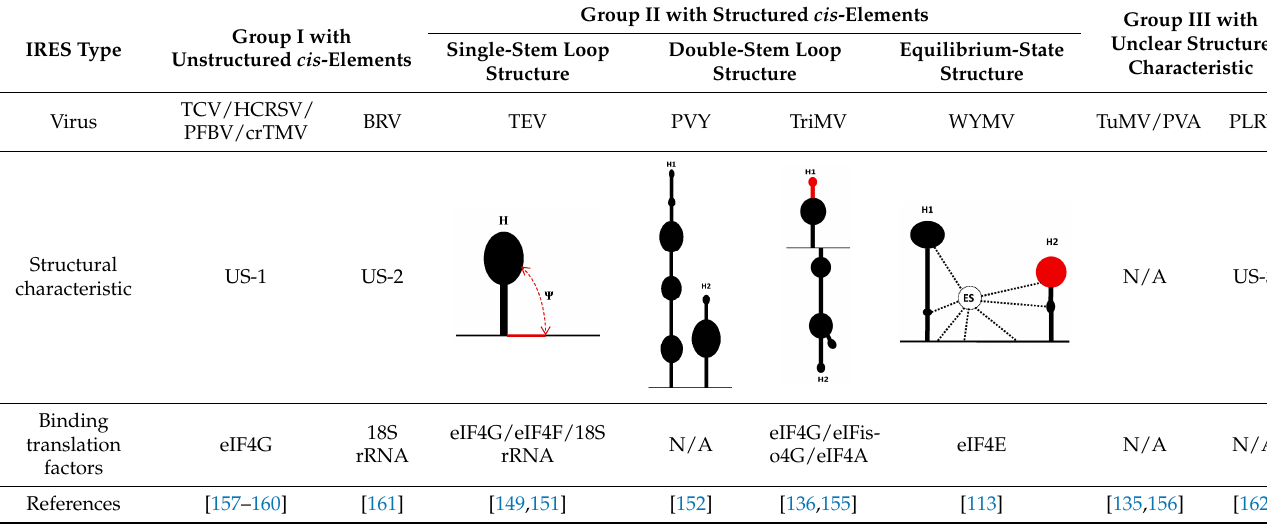
US-3, a conserved AUG codon and a reverse symmetric downstream